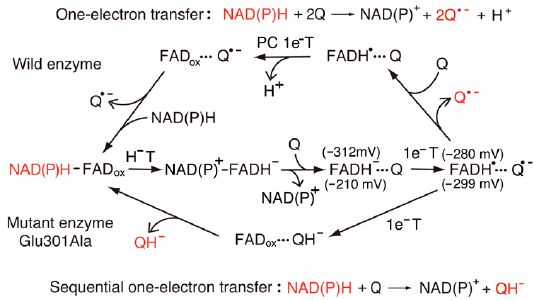
Figure 7. Proposed catalytic cycle of wild and mutant FNR Glu301Ala.